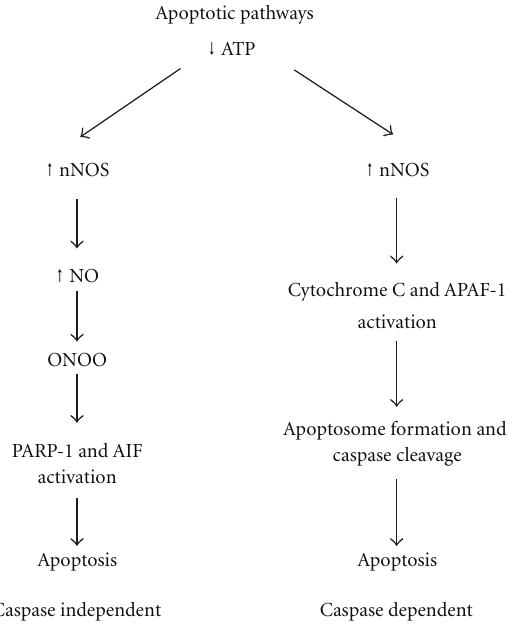
Figure 1: A diagram of the progression of caspase-independent and -dependent apoptotic